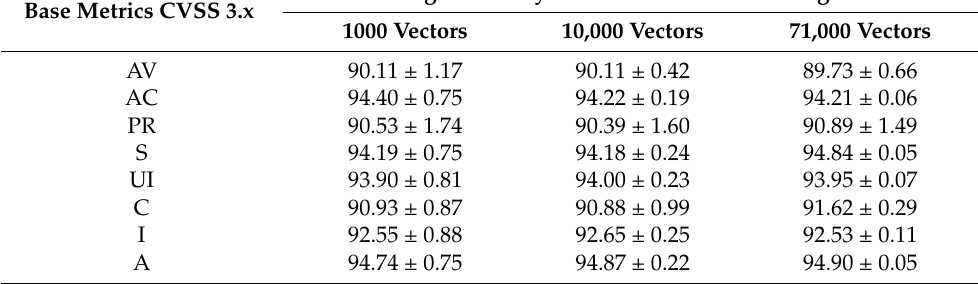
Table 5. The average accuracy of the classification of the CVSS 3.x base vector parameters achieved for the testing set of 1000, 10,000, and 71,000 elements and testing multiplicities of 50, 50, and 10 times,